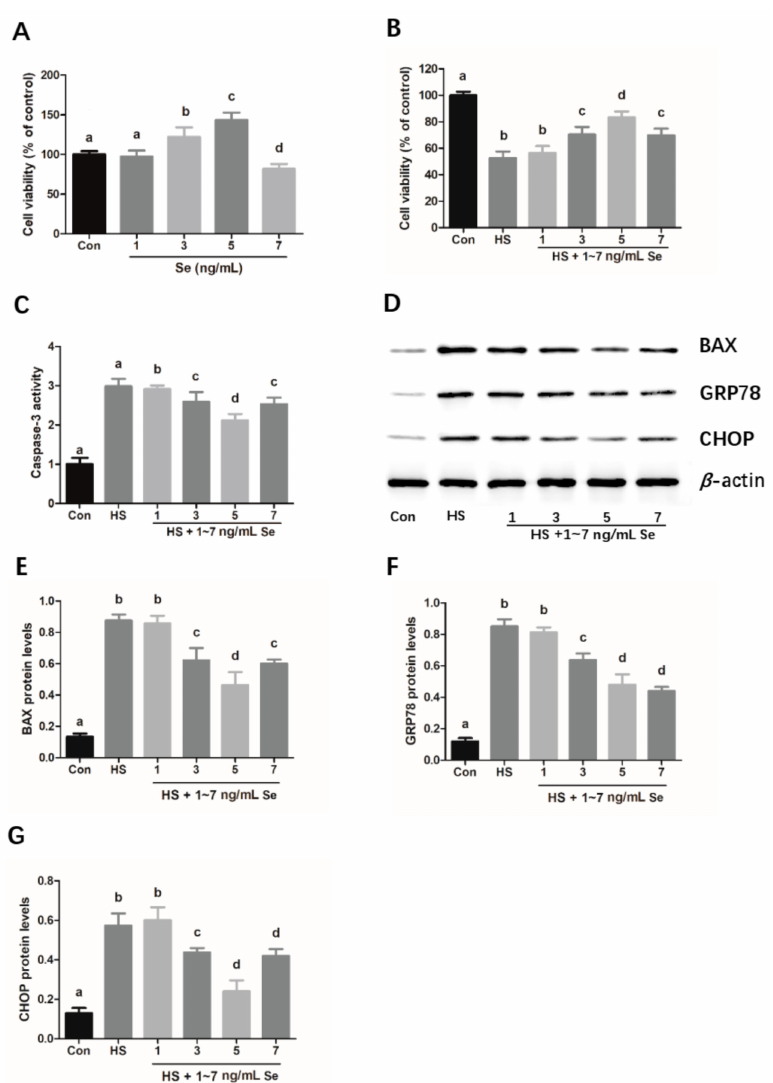
Figure 2. Sodium selenite attenuates the chronic heat stress-induced cell viability decreases and ER stress in mouse granulosa cells. Cells were treated with di ff erent concentrations of sodium selenite (1, 3, 5, and 7 ng / mL) at 37 ◦ C ( A ) or at 39 ◦ C ( B ) for 24 h, and then harvested for analyzing the cell viability by CCK-8 assay. Caspase-3 activity was analyzed using a Caspase 3 Activity Assay Kit ( C ). Western blot analysis of apoptosis-related protein BAX, ER stress activation marker GRP78 and CHOP are shown ( D ). The relative protein expression of BAX ( E ), GRP78 ( F ) and CHOP ( G ) were normalized to β -actin. The results of data analysis are shown as the bar graph. The data are presented as mean ± SEM of three independent experiments, and each independent experiment includes three technical replicates. Bars with di ff erent lowercase letters are significantly di ff erent ( p <